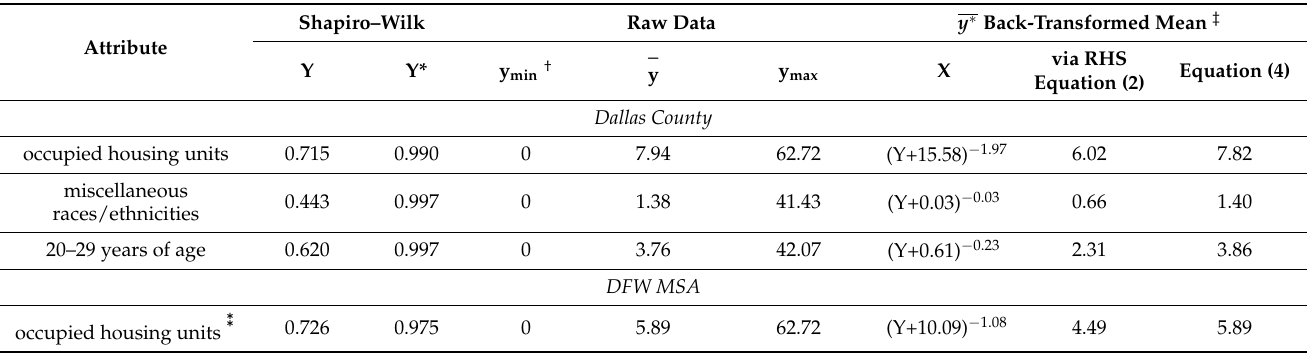
Table 3. Selected Box–Cox power transformed 2010 density attribute variables experiencing improve- ment of their individual correspondences with a Gaussian probability density function.